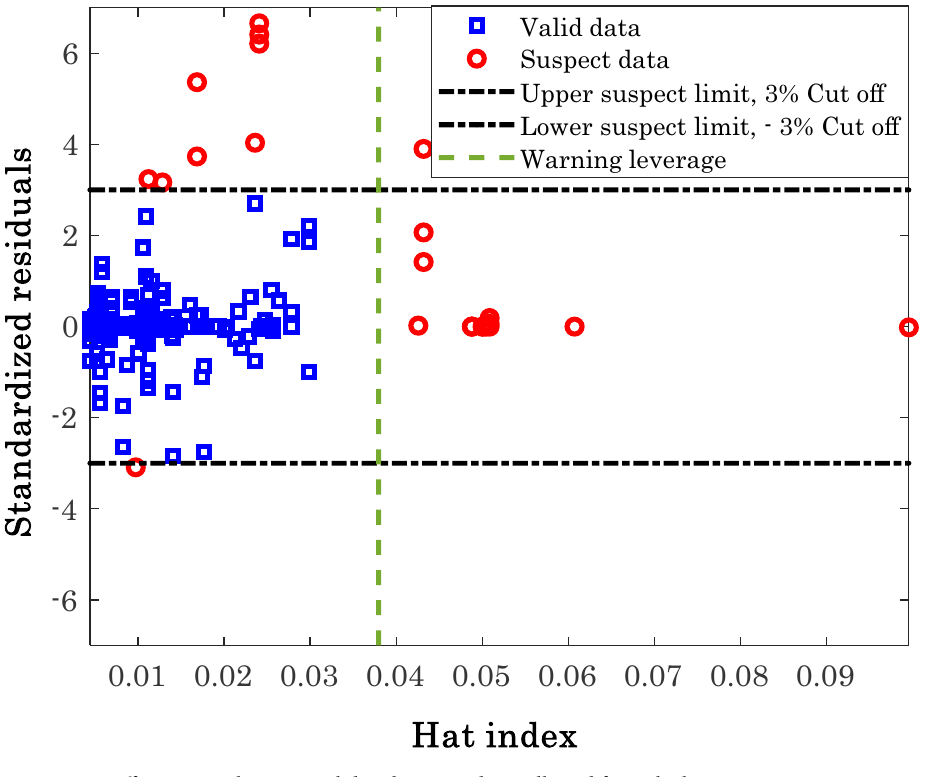
Figure 9. Differentiating between valid and suspect data collected from the